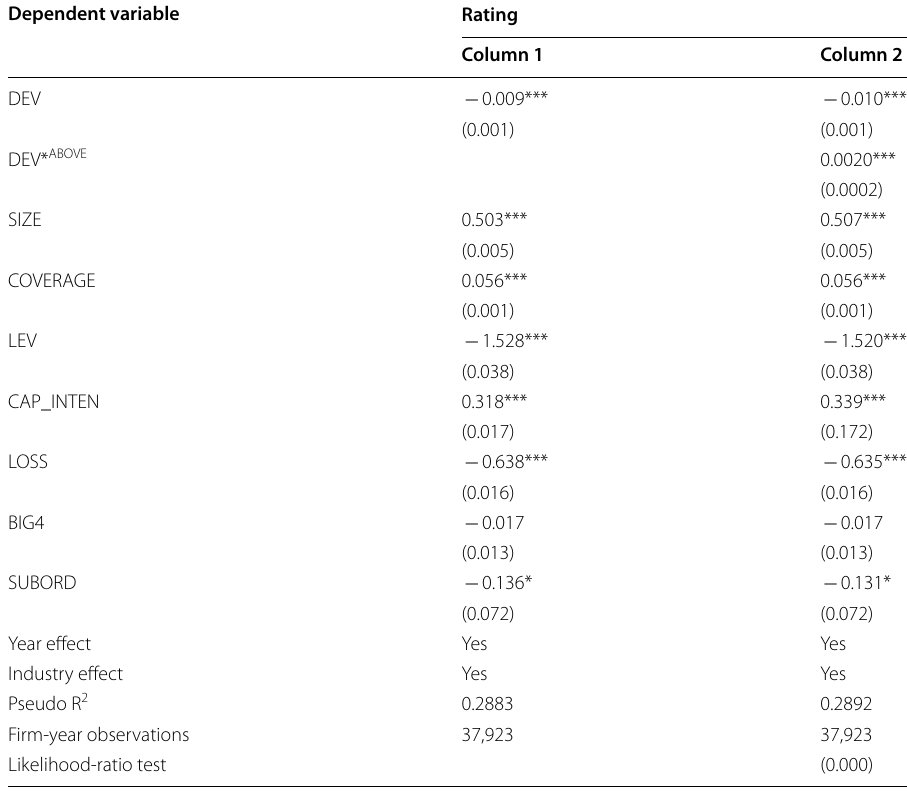
Table 8 Ordered Probit regression results of the relationship between credit rating and deviation from optimal working